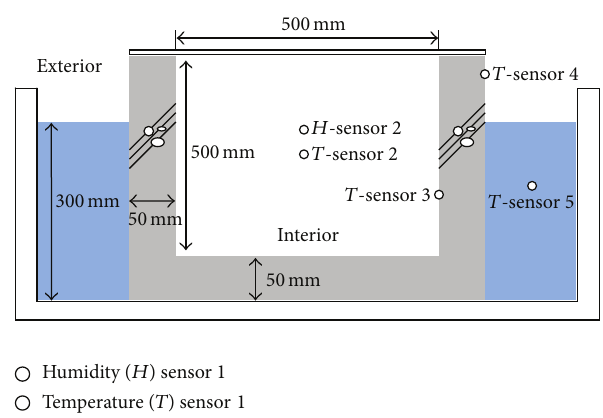
Figure 2: Schematic diagram of the